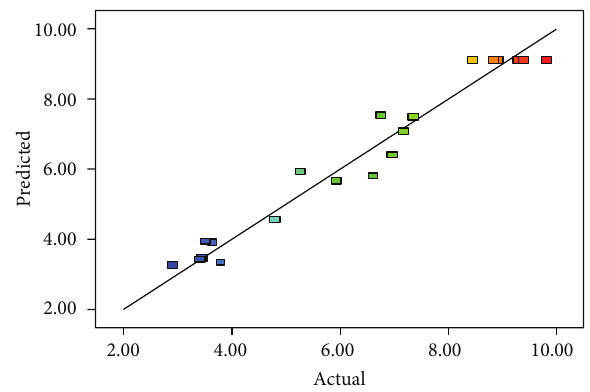
Figure 1: Predicted nonlinearity versus actual nonlinearity.